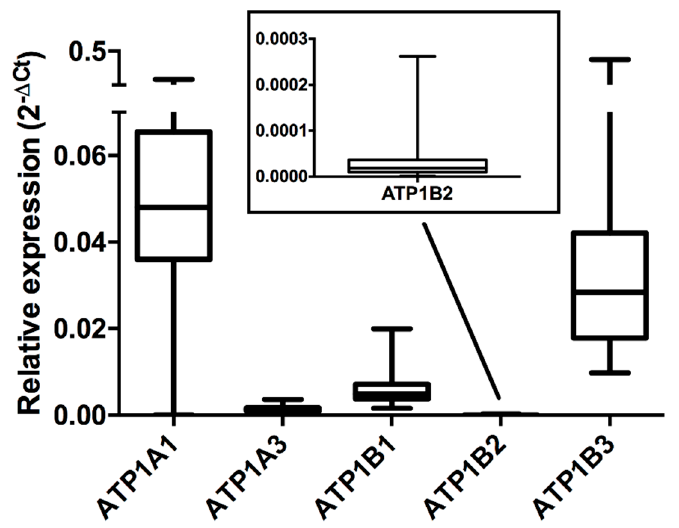
Figure 2. Distribution of relative gene expressions for the Na + / K + -ATPase α subunit isoforms (ATP1A1, ATP1A3) and β subunit isoforms (ATP1B1, ATP1B2 and ATP1B3) calculated as 2 − ∆ Ct with respect to the housekeeping ACTB gene within monocytes from the 60 healthy volunteers enrolled in the study. For each volunteer, relative expression data were the means of three experiments performed in duplicate.